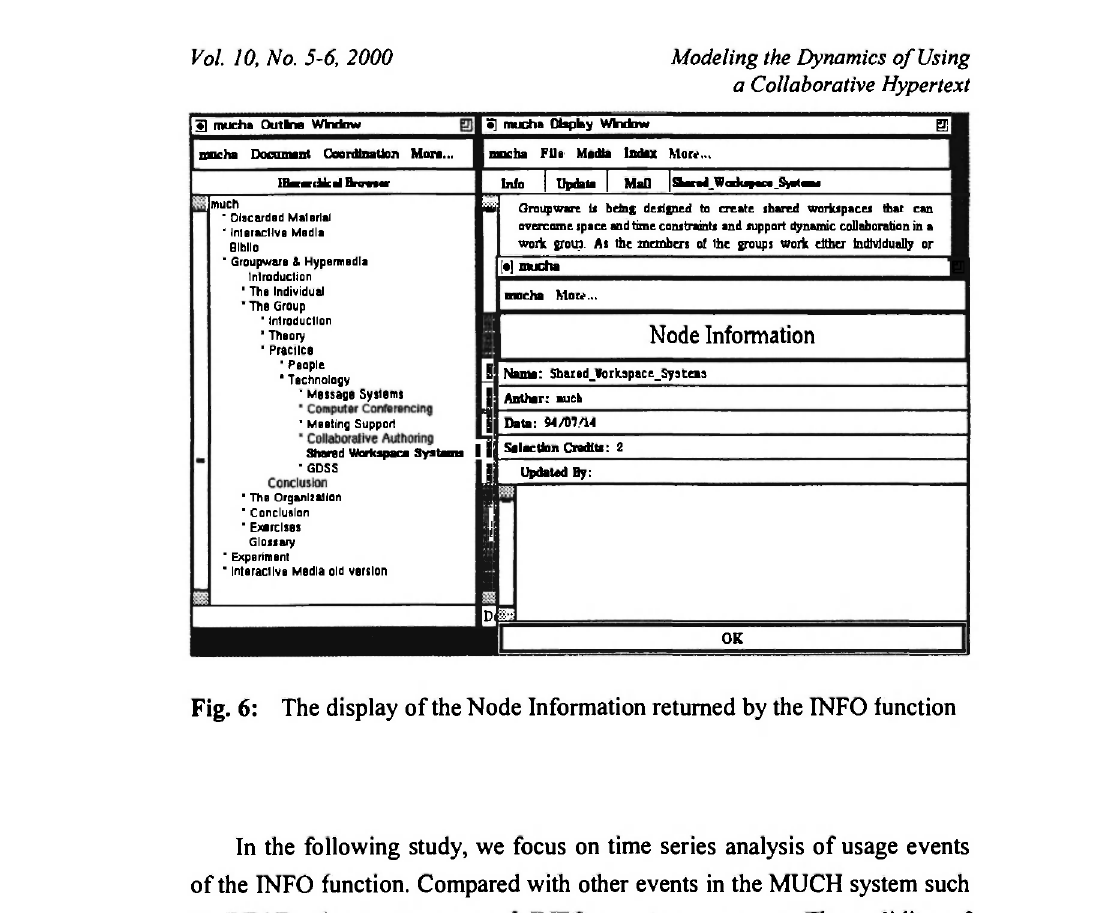
Fig. 6: The display of the Node Information returned by the INFO